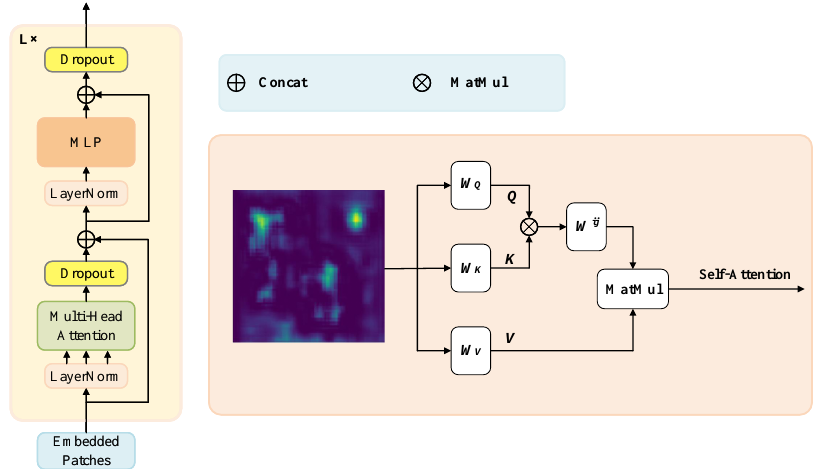
Figure 3. The architecture of the TRsB. The left side represents the transformer encoder structure, and the right side is the attention mechanism between feature